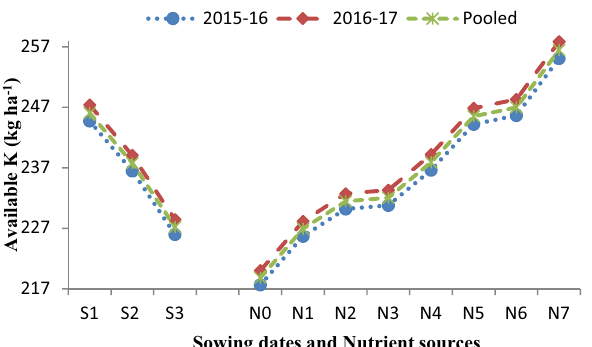
Figure 3. Effect of sowing dates and nutrient sources on available potassium (K) after the harvest of Indian mustard.